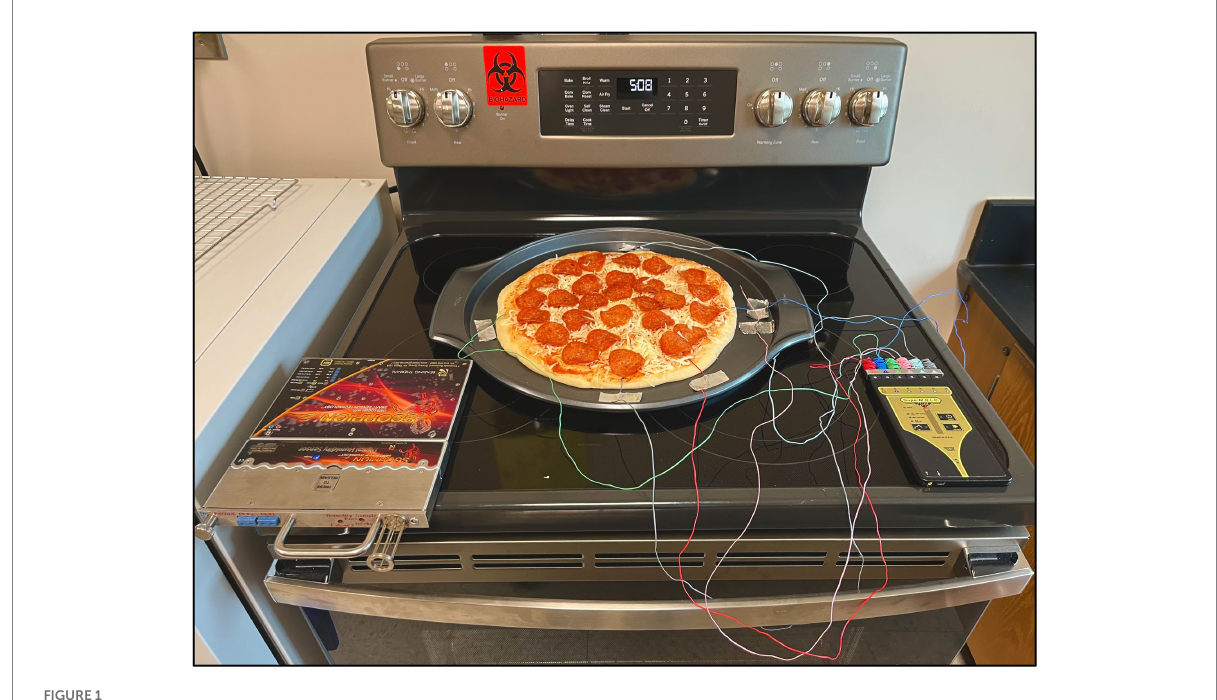
FIGURE 1 Pizza baking validation study